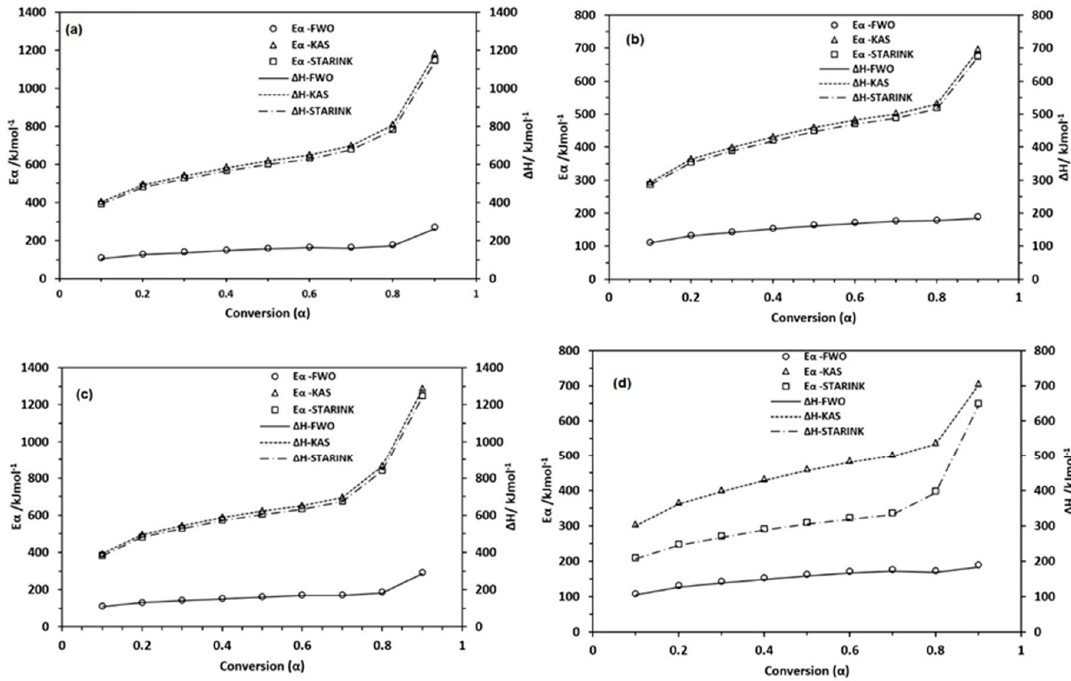
Figure 5. Combined activation energies and enthalpies of DPWP for ( a ) leaflet (L), ( b ) rachis (R), ( c ) fibers (F), and ( d ) composite (M) by three model-free methods.